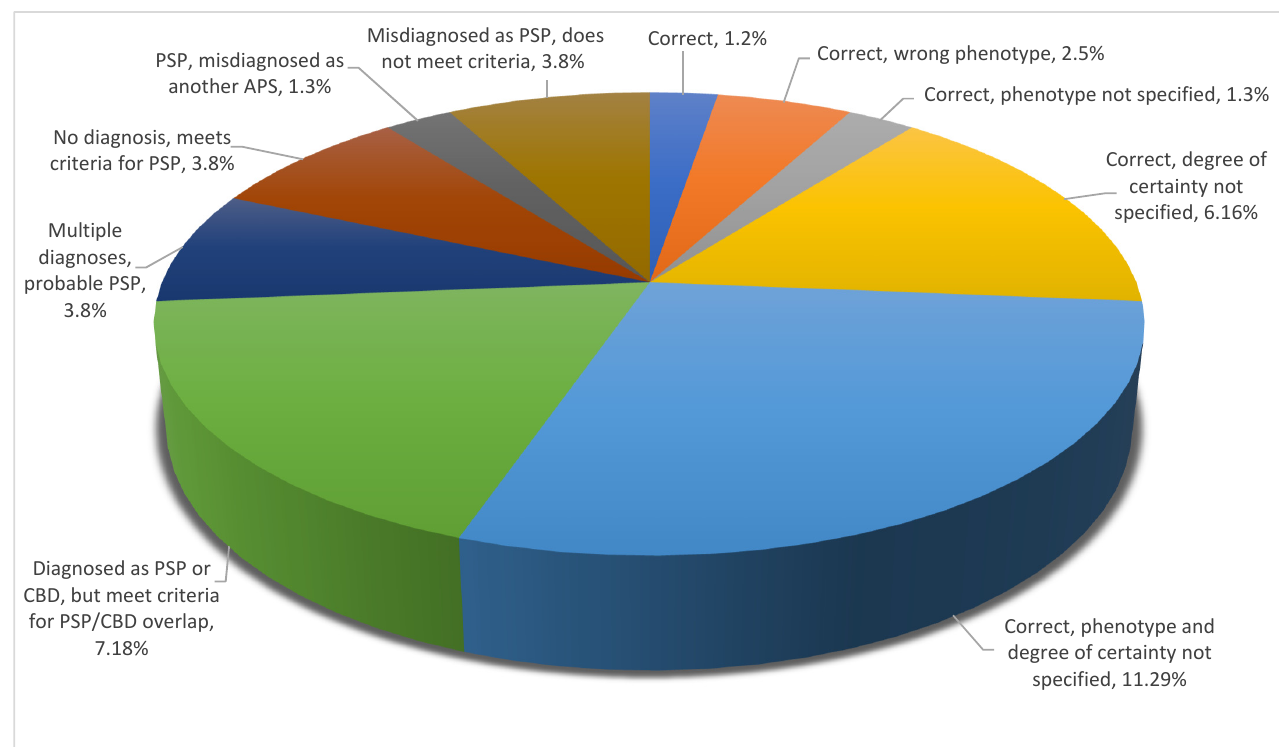
Figure 7. Diagnostic precision per type of atypical parkinsonism: PSP.